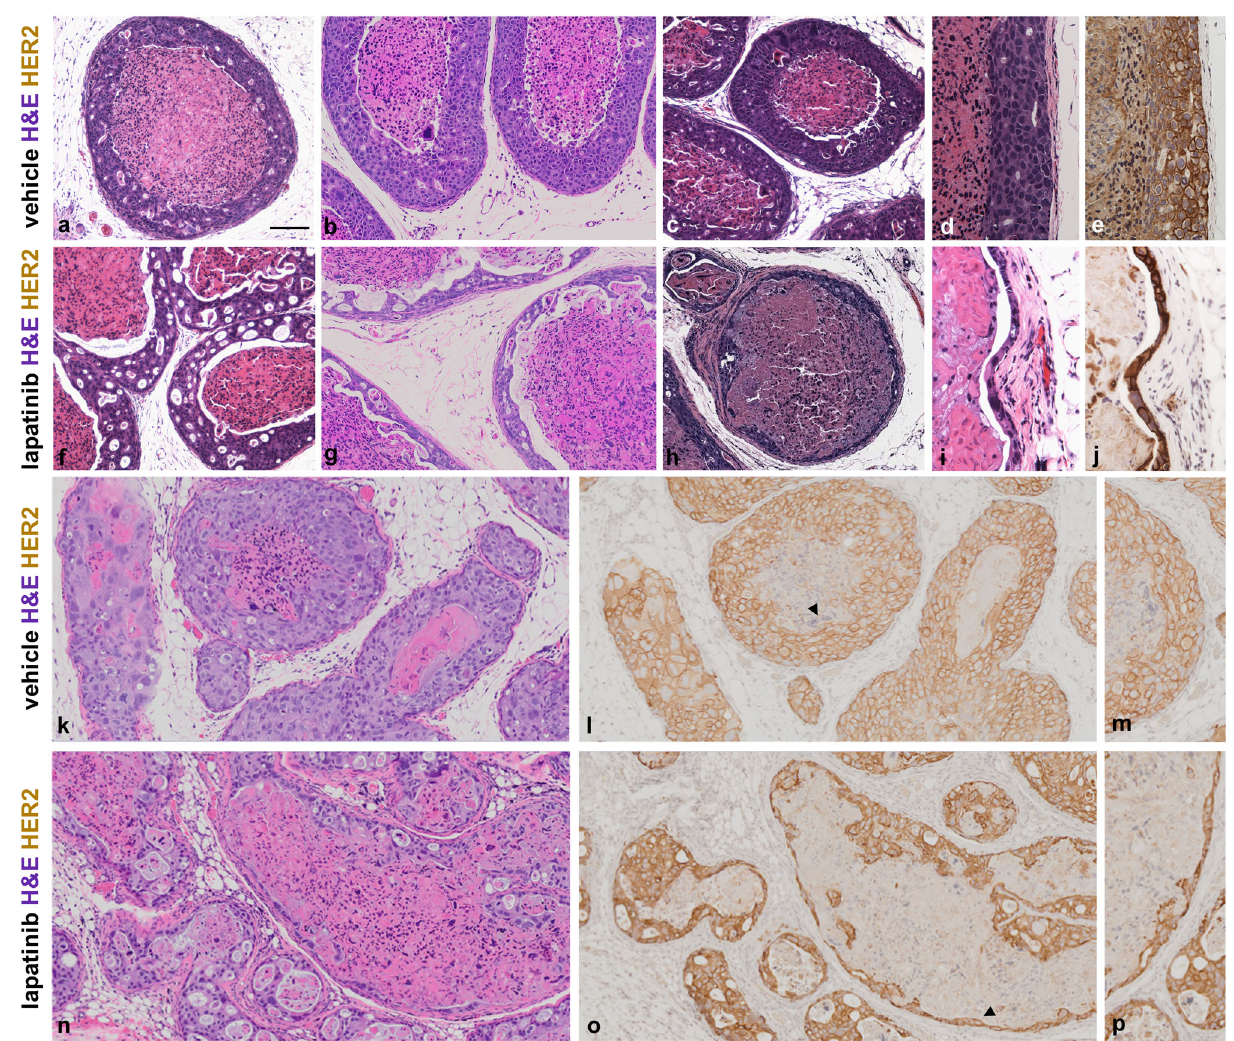
Fig. 1 Preservation of niche-localized tumor cells post-lapatinib treatment. Representative H&E images of vehicle-treated ( a – e ) and 5-day or 10-day lapatinib-treated ( f – j ) SUM225 DCIS-like tumors. Note f , g , i were 10-day whereas h was 5-day lapatinib-treated. The lapatinib-treated tumor images represent the spectrum of responses observed, with the least signi fi cant reductions in the viable tumor cell content shown in ( f ). Note cell crypts (vacuole-like spaces throughout the cell layer) associated with the areas of cell death. More signi fi cant reduction in the viable tumor cell content is shown in ( g , h ), with maintenance of only the outermost layer of tumor cells adjacent to myoepithelial cells and BM in ( h ). HER2 immunostains con fi rm HER2 status among the residual tumor cell population ( j ). H&E ( d , i ) and serial section HER2 IHC ( e , j ) are presented. Note d , e , i , j represent longitudinal sections, whereas all other panels represent transverse sections, through the intraductal tumors. Comparison of vehicle ( k – m ) and 21-day lapatinib-treated ( n – p ) SUM225 tumors. Representative H&E ( k , n ) and serial section HER2 IHC ( l , m ) and ( o , p ) are presented. Arrowheads in l , o highlight the regions in m , p . Note preservation of the niche-localized HER2+ tumor cells post-long term lapatinib treatment ( p ). Scale bar, ~200 μ